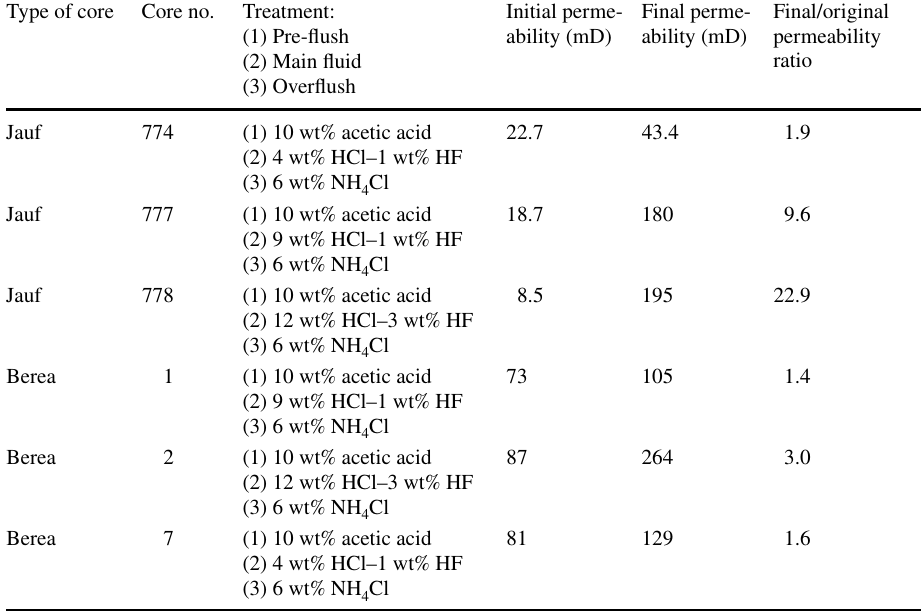
Type of core Core